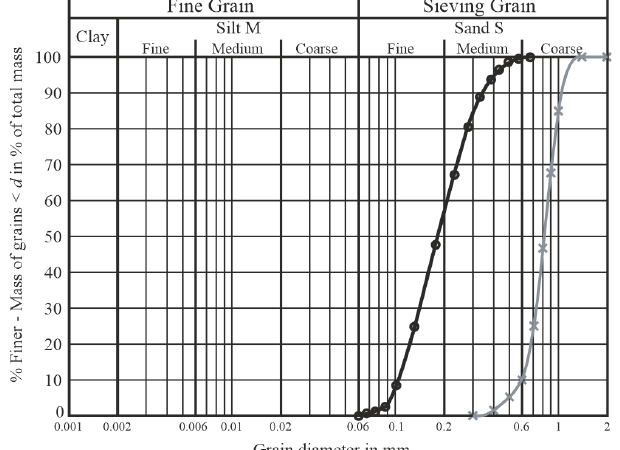
Figure 4. Grain size distribution of F34 (black) and S40T (grey) silica